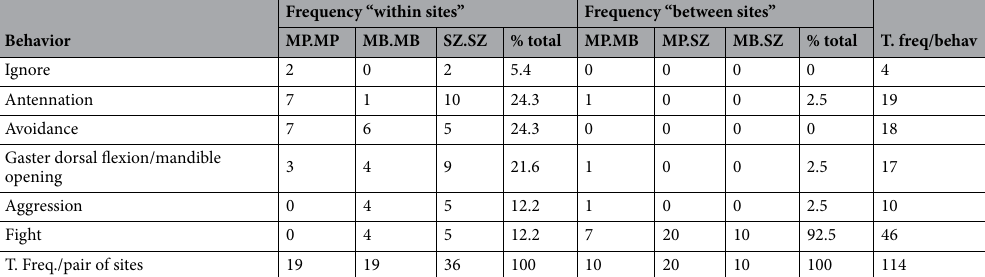
Table 1. Outcomes from behavioral trails performed with ten A. muelleri ant individuals (five from each colony) placed in a plastic arena for 5 min. The table shows the frequency (number of times) and the percentage (% total) that each behavior was scored in each trial where the ants (pair of nests) belonged to the same site (“within sites”) or different sites (“between sites”). Total number of behaviors from all trials (T. freq./behav.). Total number of behaviors from each pair of sites (T. Freq./pair of sites). SZ—“Seu zé”; MB—“Mata da Biologia” and MP—“Mata do paraíso”.